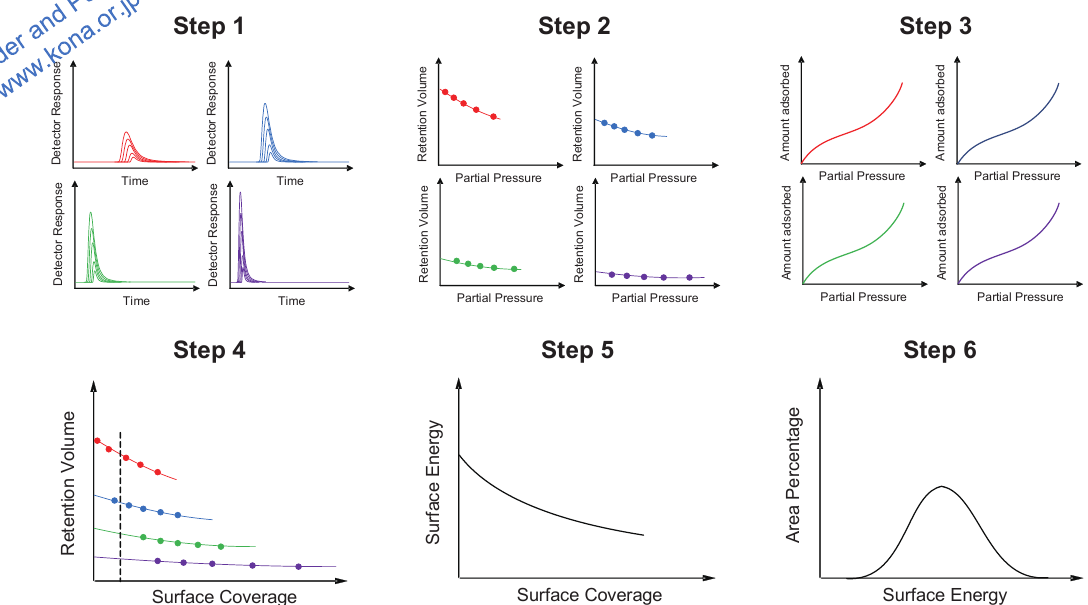
Fig. 6 Determination of surface energy distribution by